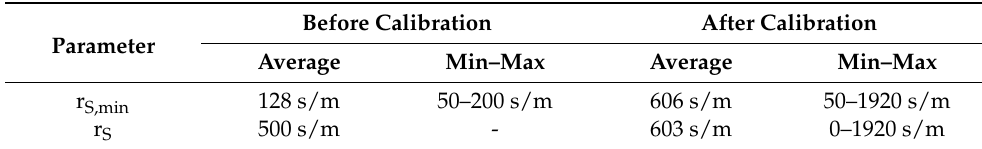
Table 2. Parameter statistics before and after the calibration